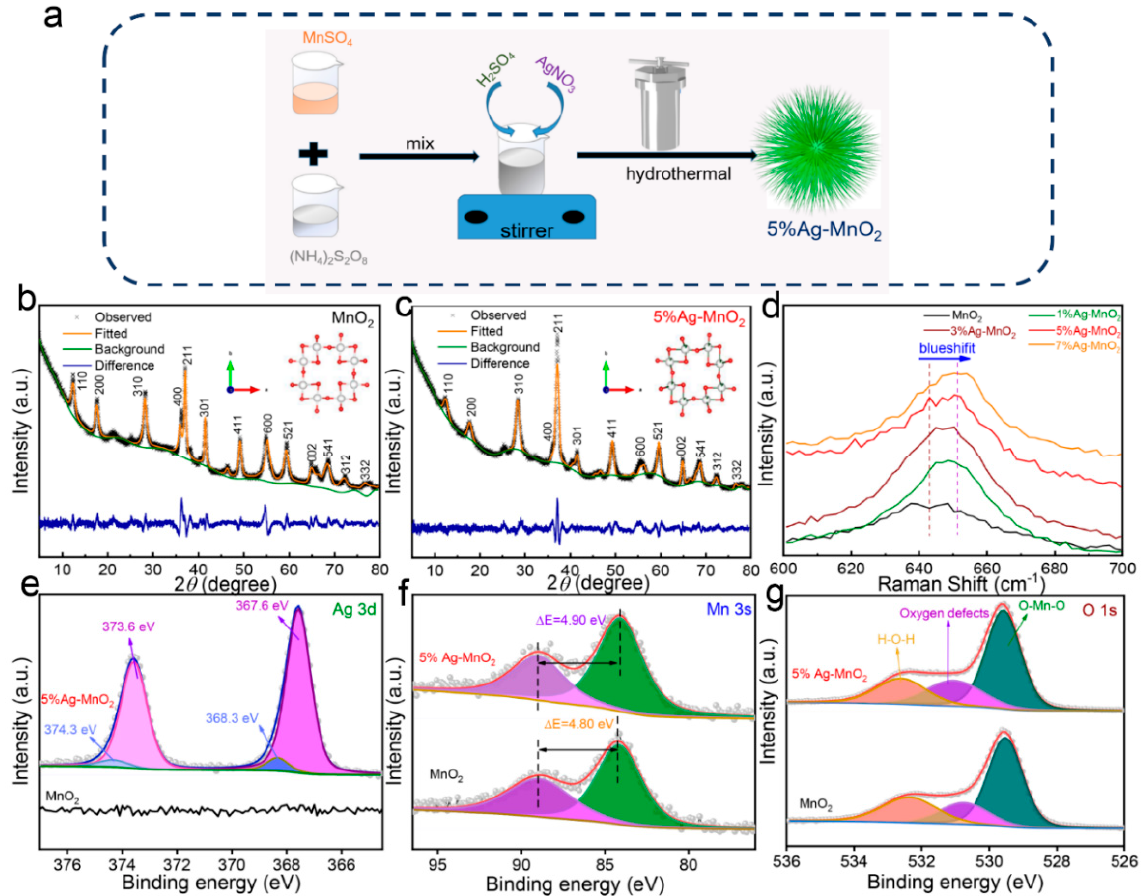
b = 9.94 Å, c = 2.87 Å, α = 90 ◦ , β = 90 ◦ , and γ = 90 ◦ . However, the lattice parameters are transformed to a = 9.91 Å, b = 9.91 Å, c = 2.87 Å, α = 90 ◦ , β = 90 ◦ , and γ = 90 ◦ , when doped with Ag. Raman spectra of Ag-doped MnO 2 and pure MnO 2 are shown in Figure 1d. The peak at 640 cm − 1 belongs to the stretching vibration of Mn-O, which exhibits an obvious blueshift for MnO 2 doped with increased amounts of Ag owing to increased Mn 3+ content [35,36]. Chemical composition and their surface electronic states were analyzed by XPS spectra. Photoelectron emission peak from Ag element can be positively observed in the wide-scan spectrum of 5%Ag-MnO 2 (Figure S2), confirming successful doping of Ag into MnO 2 . Figure 1e presents the high-resolution XPS spectrum from Ag 3d electrons of 5%Ag-MnO 2 . The peaks at 367.6 and 373.6 eV belong to 3d 5/2 and 3d 3/2 photoelectrons of Ag + , respectively [37]. Meanwhile, the peaks at 368.3 and 374.3 eV correspond to the standard values of metallic Ag [38]. As shown in Figure 1f, the high-resolution Mn 3s spectrum of 5%Ag-MnO 2 exhibits a spin-energy separation of 4.9 eV, which is higher than that of pure MnO 2 . Therefore, Mn elements in 5%Ag-MnO 2 has a lower chemical valence than that in pure MnO 2 owing to Ag doping [39]. The high-resolution O 1s spectrum can be fitted into three peaks (Figure 1g). The peaks of 529.6, 531.1, and 532.7 eV are related to Mn- O, oxygen defects, and adsorbed water [40]. The calculated area ratios of oxygen defects increase from 19% to 23% after introducing Ag into MnO 2 . Increased amount of oxygen defect will give rise to narrower band gap and faster electron migration rates, and thus higher reaction activity and fast reaction kinetics can be anticipated for 5%Ag-MnO 2 [41].